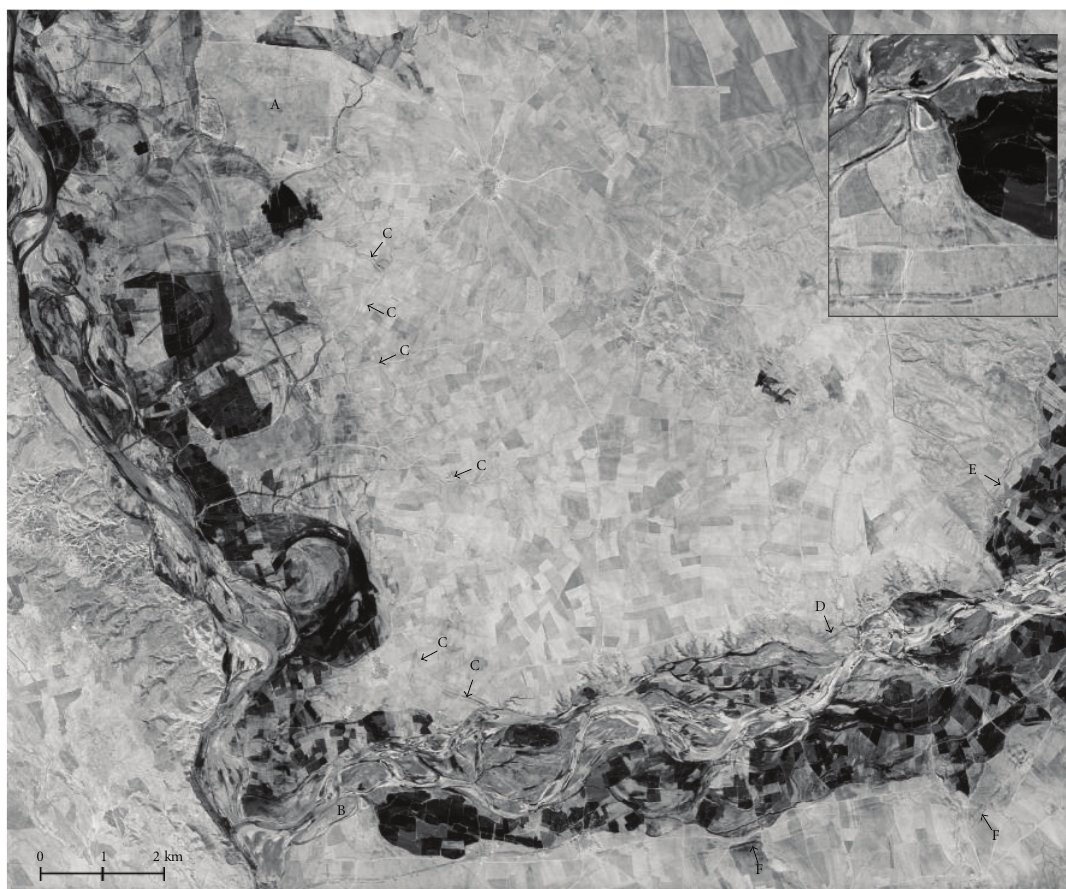
Figure 9: The territory of Kalhu (A) in a Corona KH-4B photo of 1968; Tell Kashaf (B) and traces and remains of the Assyrian canal named Patti-nuˇsi (C, D, and E) and of another canal dated post the Neo-Assyrian period can be seen (F); an enlargement of the image shows the Assyrian settlement of Tell Kashaf, strategically located very near to the juncture of the Upper Zab and the Tigris. Nahr Qanausa. Both canals tapped the Tigris in a location that is about 25 km north of Ashur and lied roughly north- south parallel the river; they have clear spoil heaps and are both relatively wide and long. The Pattu-m¯eˇsari defined the eastern boundary of Kar-Tukulti-Ninurta and extended well north of the city, crossing also the area of Tell Haikal (may be the ancient Ekallate), a site located 15 km north of Ashur and next to the Tigris on the east bank; it was occupied in the Middle Assyrian, Neo-Assyrian and post-Assyrian